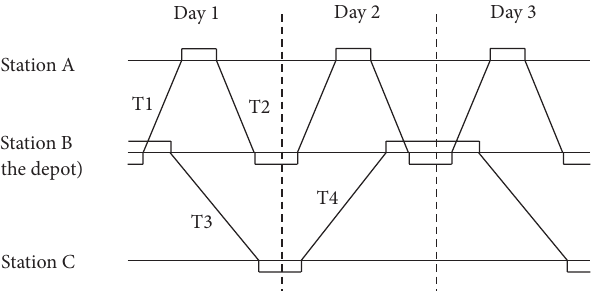
Figure 1: A diagrammatic sketch of